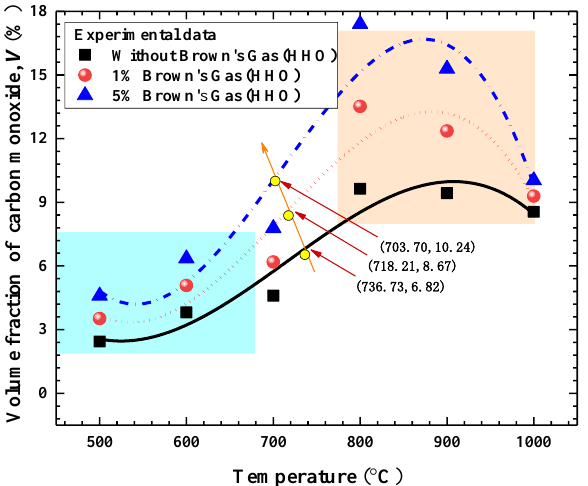
Figure 10. Variation of CO volume fraction with temperature.